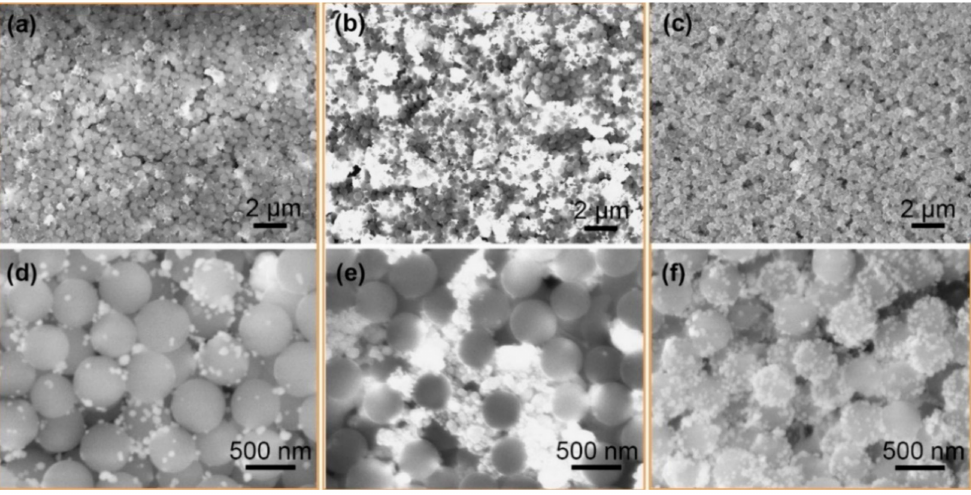
Figure 4. SEM images of SiO 2 @Ag nanosphere substrate with 3 different samples: ( a ) S1, ( b ) S2, and ( c ) S3; and the corresponding magnification enlarged by 6 times ( d ) S1, ( e ) S2, and ( f ) S3.